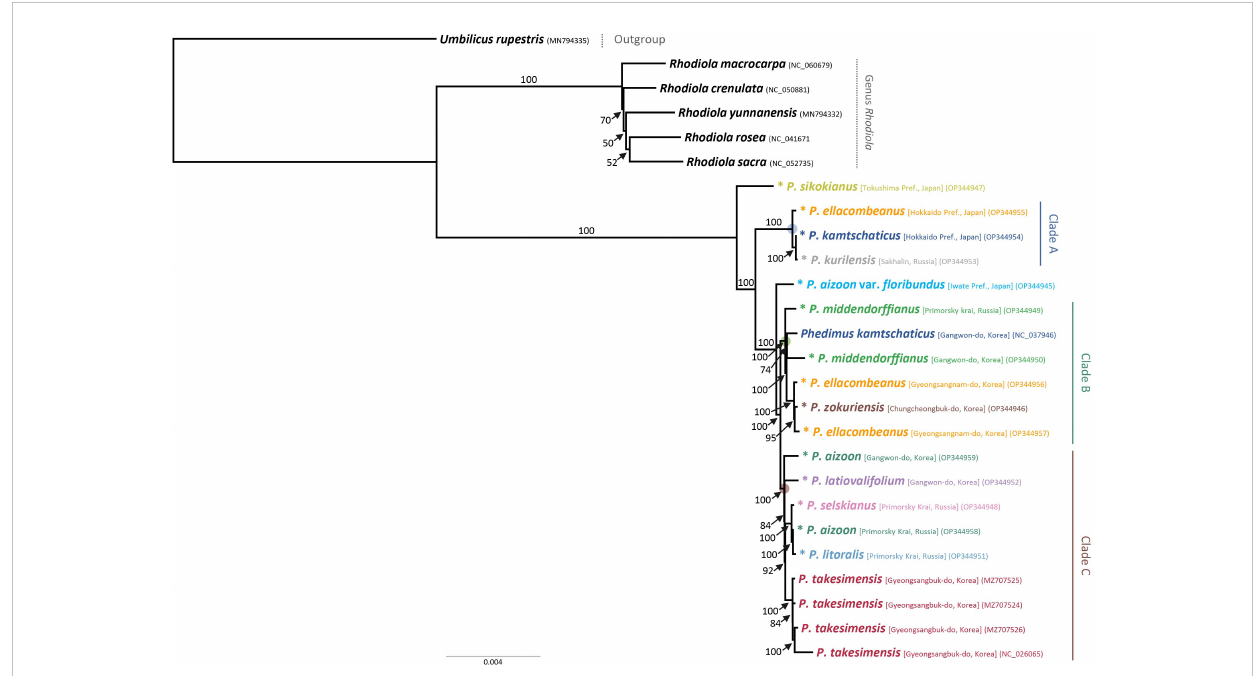
FIGURE 4 Maximum likelihood phylogeny of subg. Aizoon , including 11 species of Phedimus , based on complete plastome sequences. Bootstrap support values >50% are shown above and below branches. Asterisked 15 accessions are newly obtained in this study.